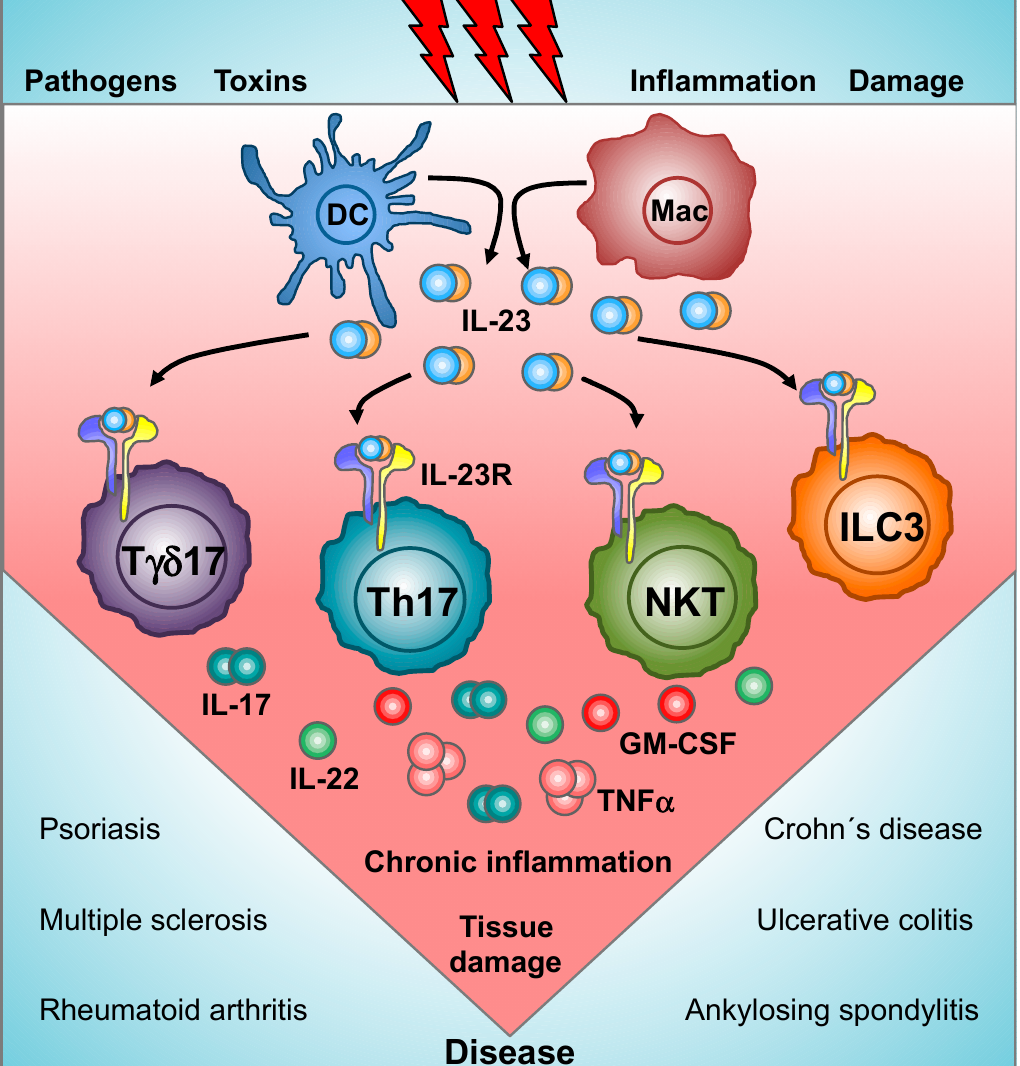
Figure 1. Role of interleukin 23 (IL-23) in chronic inflammatory diseases. IL-23 is produced by dendritic cells (DCs) and activated macrophages, and its actions are mainly mediated by the CD4 T helper subset Th17, a distinct subpopulation of gamma / delta T cells (T γδ 17 cells), subsets of natural killer T (NKT) cells, and type 3 innate lymphoid cells (ILC3s). IL-23 signaling promotes the production of pro-inflammatory mediators (IL-17, IL-22, granulocyte-macrophage colony-stimulating (GM-CSF), or the tumor necrosis factor (TNF α )) by target populations. These pathogenic mediators promote the recruitment and activation of granulocytes and macrophages, causing the tissue damage that induce chronic inflammation and, finally, the development of clinical symptoms.